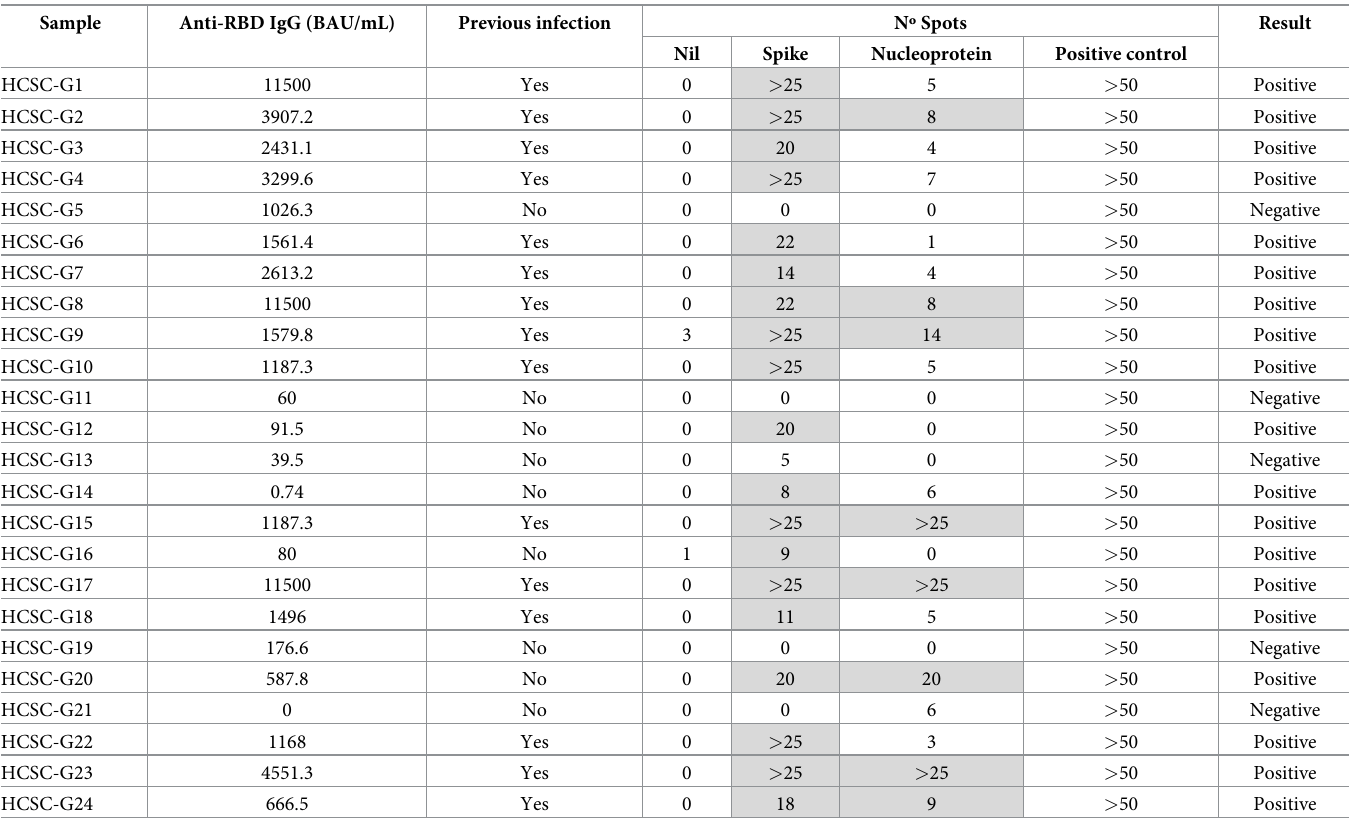
Table 2. Cellular immunity in 24 residents with different levels of anti-RBD IgG.